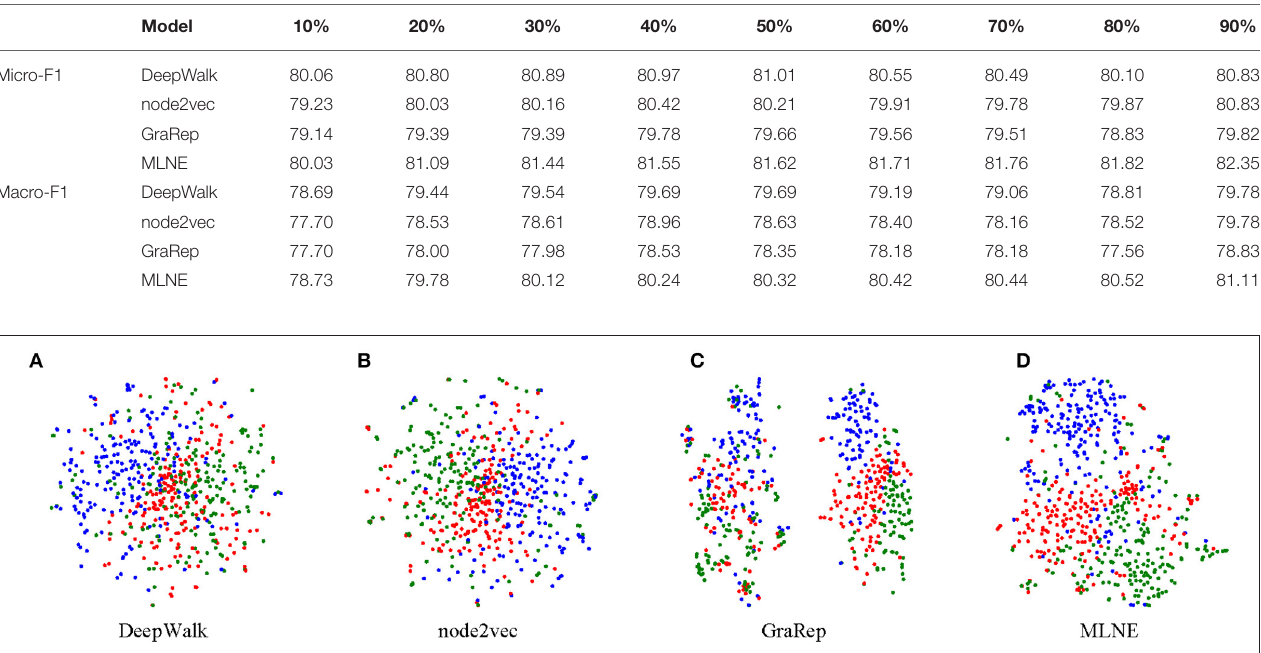
FIGURE 5 | Visualization of 20-NEWSGROUP. Each point represents a document. The color indicates the category of each document. (A) is the result of DeepWalk, (B) is the result of node2vec, (C) is the result of GraRep, and (D) is the result of the proposed